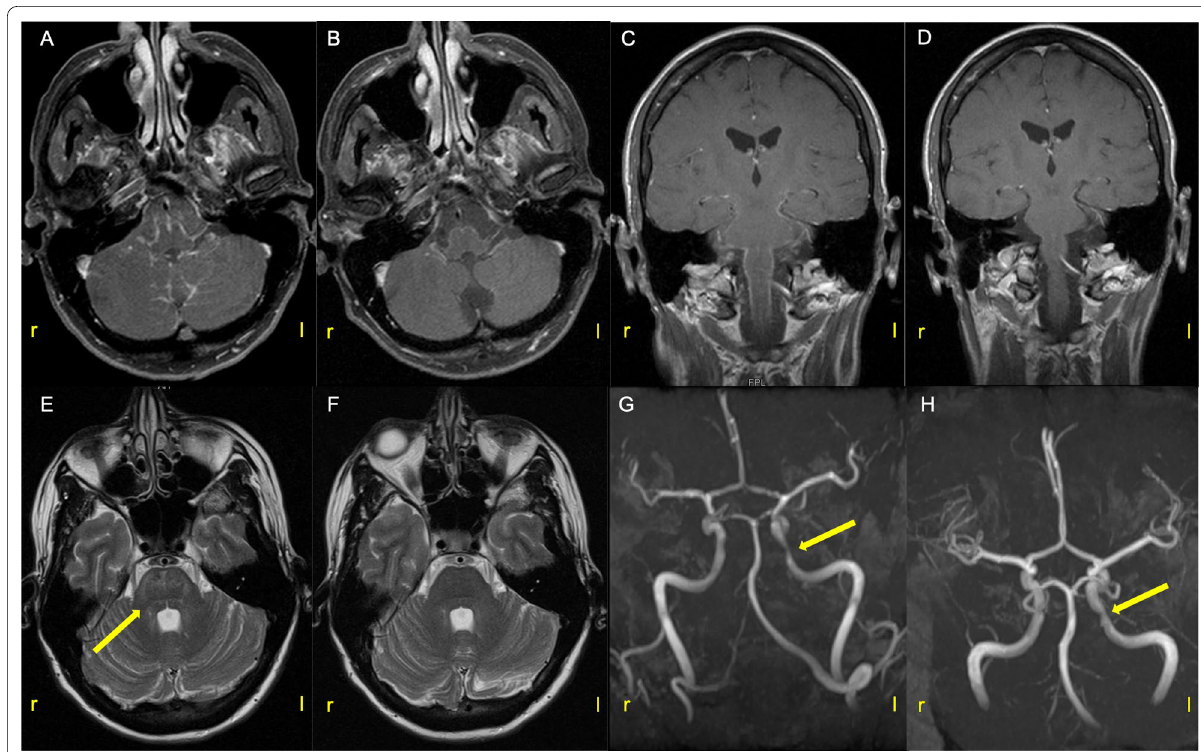
Fig. 1 MRI of the brain shows gadolinium‑enhancement along the brainstem, cerebellum, occipital and temporal sulci ( A and C before treatment), which decreased during the course ( B and D ten days after). T2‑hyperintesities could be detected in the brainstem up to the diencephalon (primarily thalamus and parts of the capsula interna on both sides). E shows the MRI before start of treatment, F four months after. G shows MR‑TOF angiography with distal ACI stenosis on the left, H 4 months later (arrows). A , B axial T1; C , D coronal T1; E , F axial T2; G , H MR‑TOF